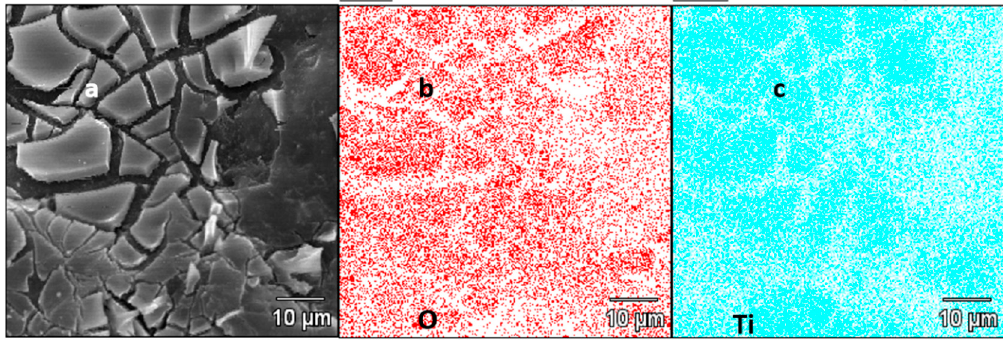
Figure 4. ( a ) SEM image of the AC + TiO 2 sample and its ( b ) EDX concentration map of O and ( c ) EDX concentration map of Ti.